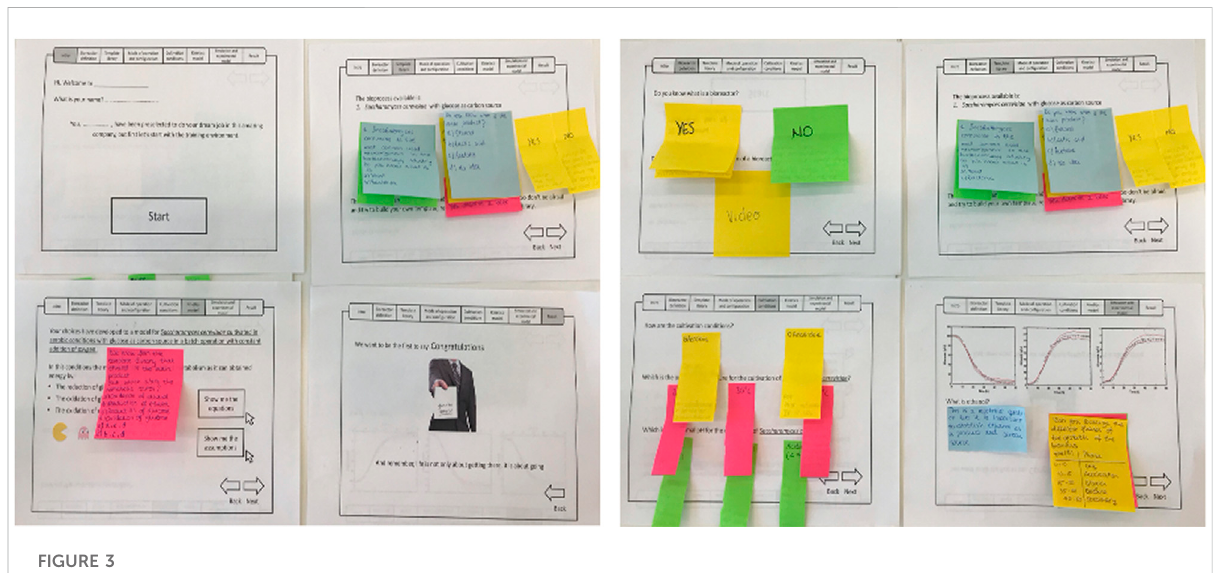
FIGURE 3 Paper prototype for participatory design (de las Heras,